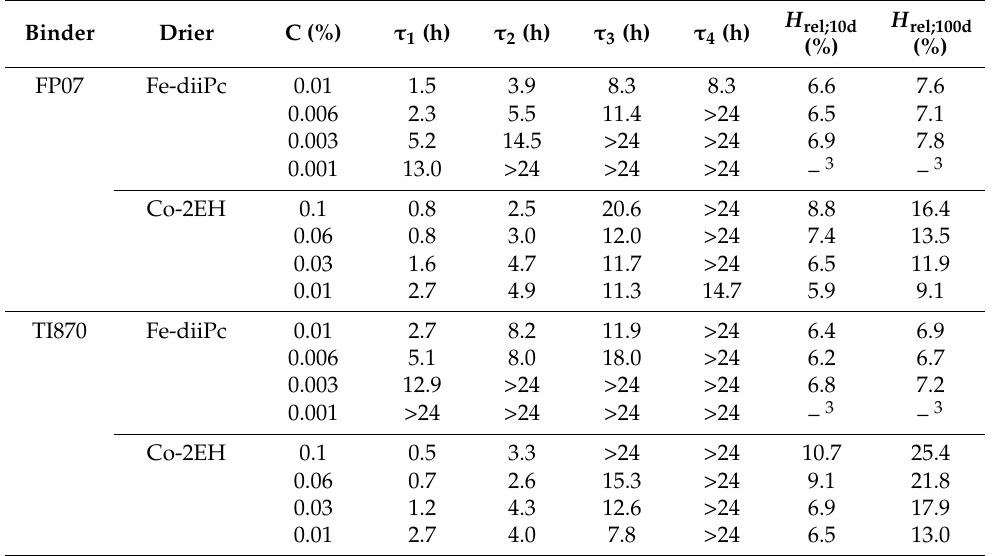
Table 2. Drying times 1 and relative hardness 2 of high-solid alkyd formulations. Binder